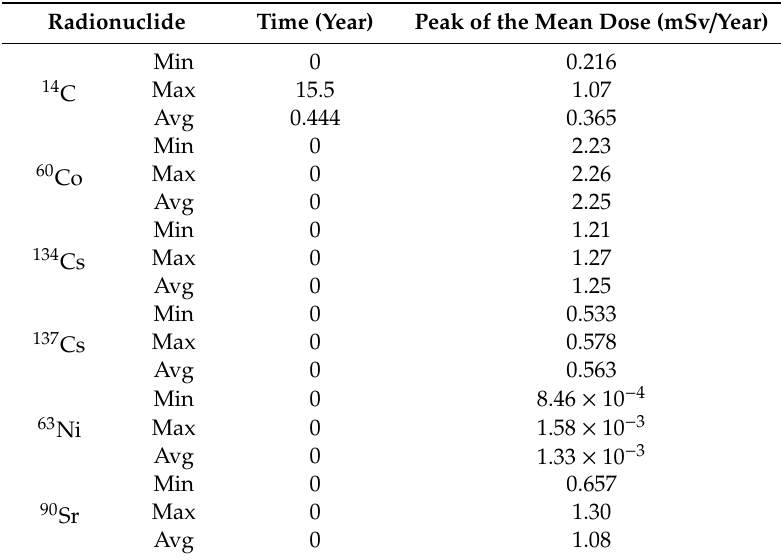
Table 8. Probabilistic dose of each radionuclide.